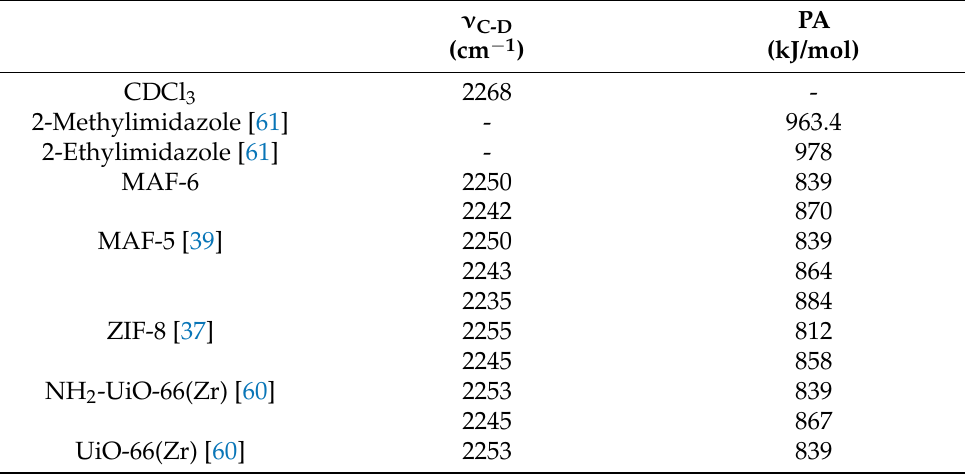
Table 4. Basicity of different catalytic systems according to adsorption of CDCl